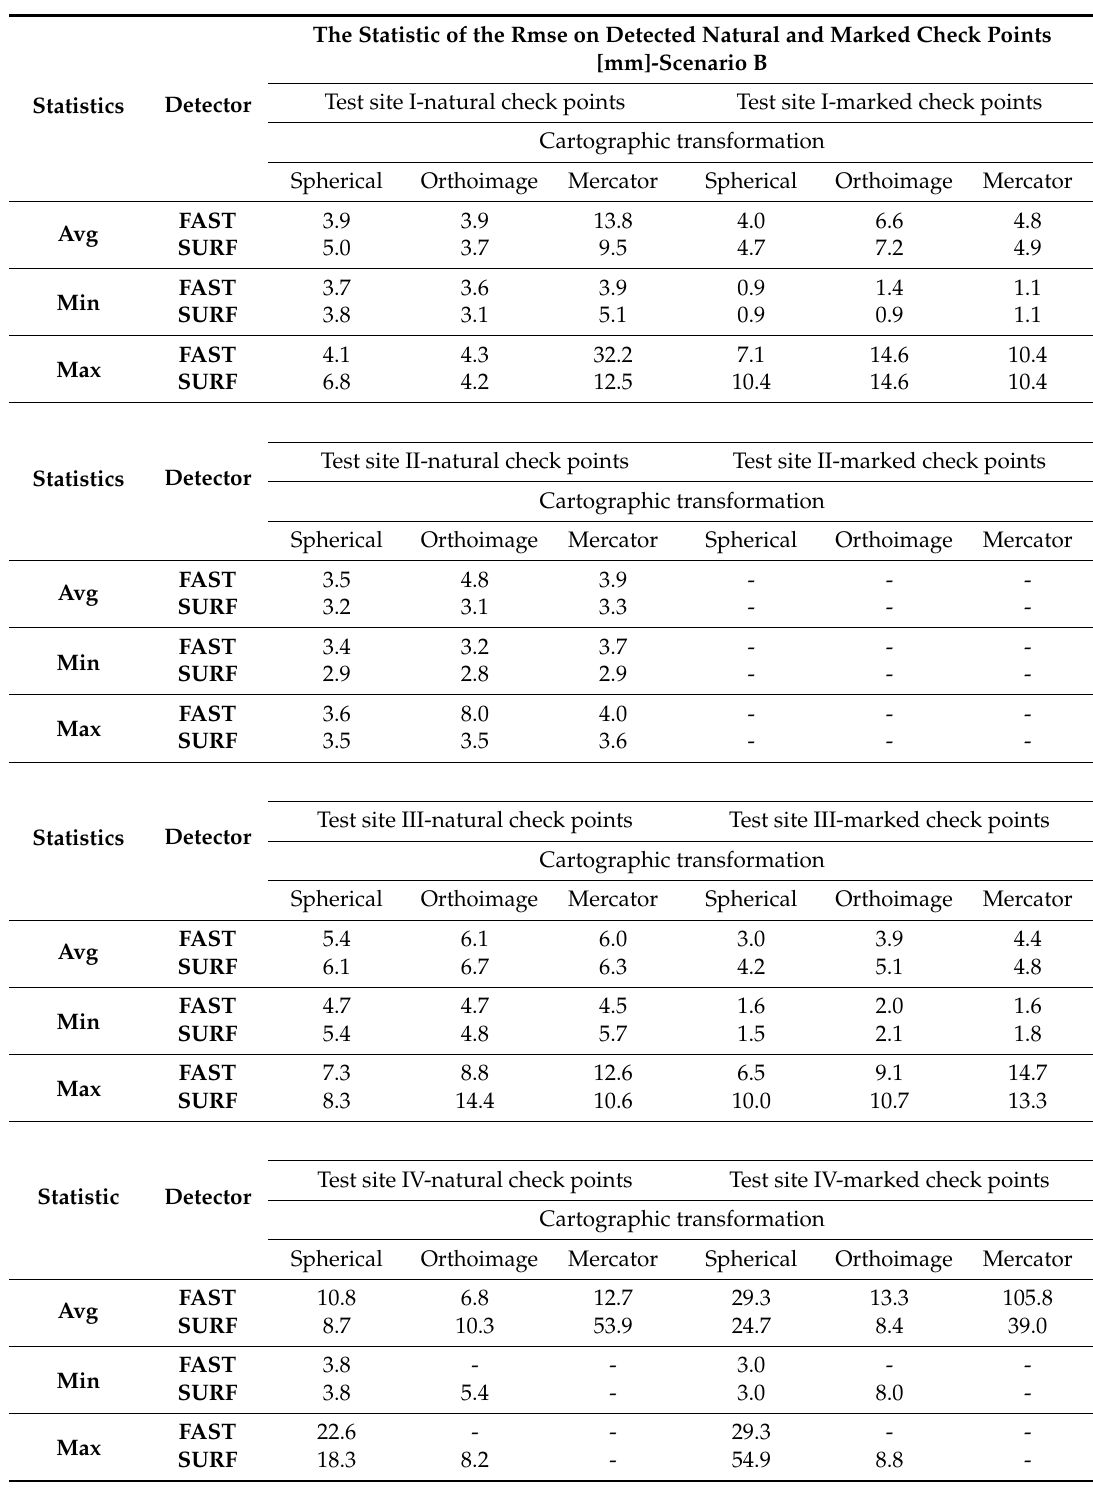
Table 11. The statistics of the RMSE values on natural and marked check points for all test sites (scenario